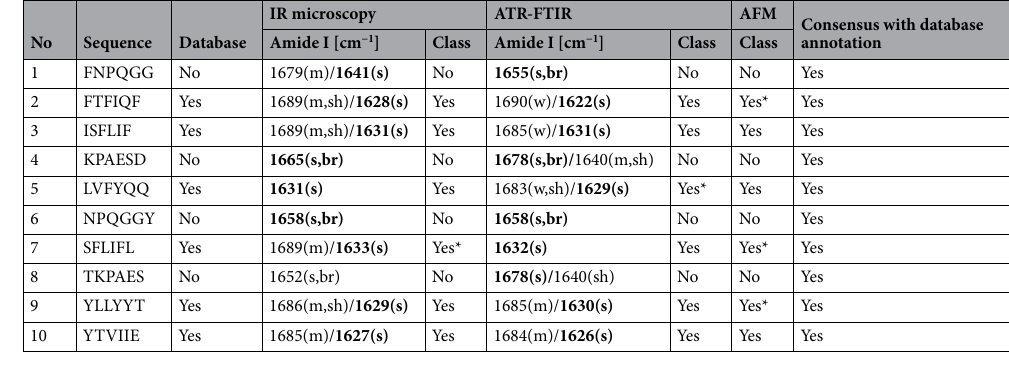
Table 1. Reference data set of sequences and their amyloid propensity by different experimental methods (’Yes’—identified as amyloid, ’No’—non-amyloid, ’Yes*’—oligomer, ’s’—strong band, ’m’—medium band, ’w’— weak band, ’br’—broad band, ’sh’—shoulder band, band maxima in bold). The results agree with the original database annotations, which were also in agreement with AmyloGram